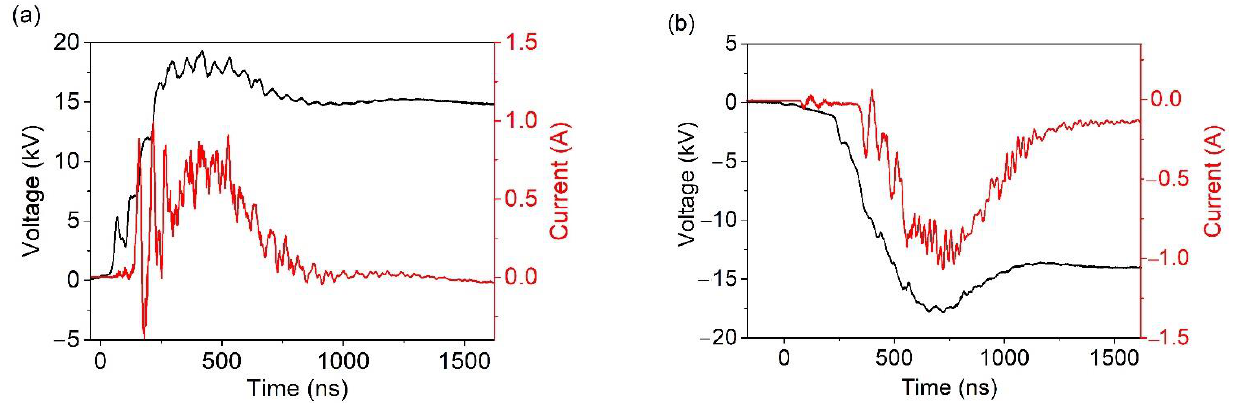
Figure 4. Typical discharge voltage and current waveforms for ( a ) positive pulse, and ( b ) negative pulse.